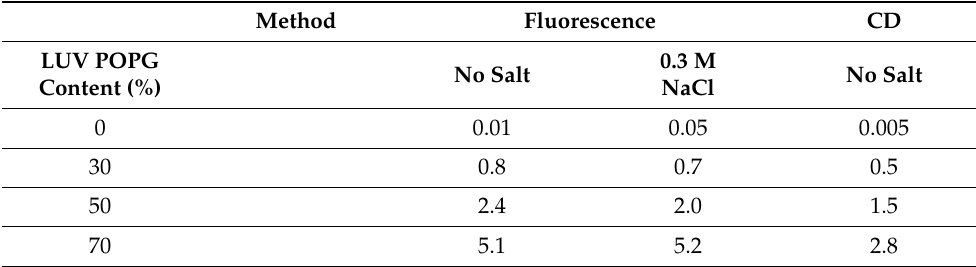
Table 1. Apparent binding constants (K App , × 10 5 M − 1 ) calculated fluorescence and circular dichro- ism (CD)